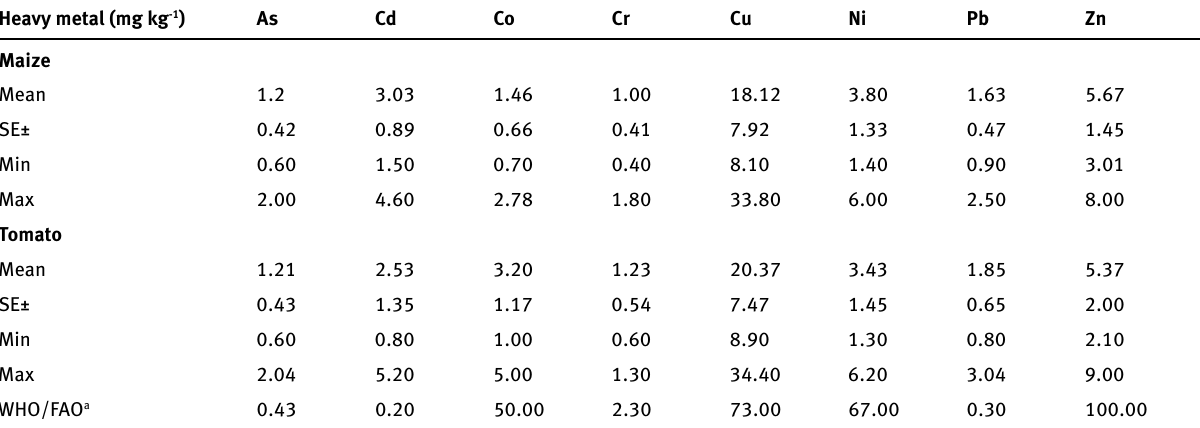
Table 2: Comparison of mean concentration of heavy metals (mg kg -1 ) in Maize and tomato with maximum allowable limits of heavy metal in vegetables Heavy metal (mg kg -1